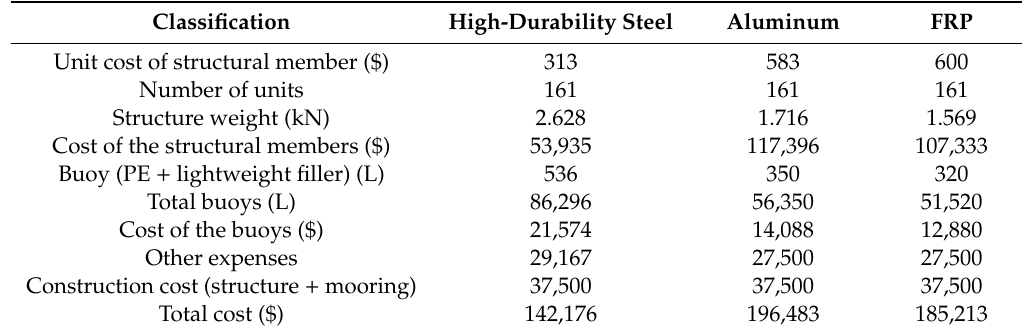
Table 2. Review of the economic feasibility of a floating photovoltaic power generation structure with respect to the structural